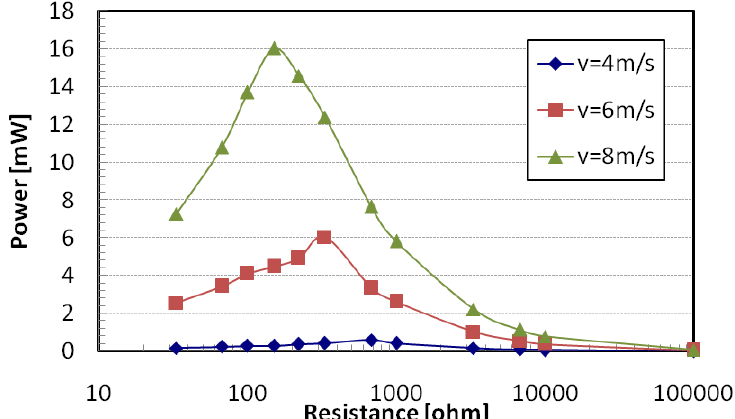
Figure 13. Power values of the tested airflow harvester for different airflow speeds and loads.